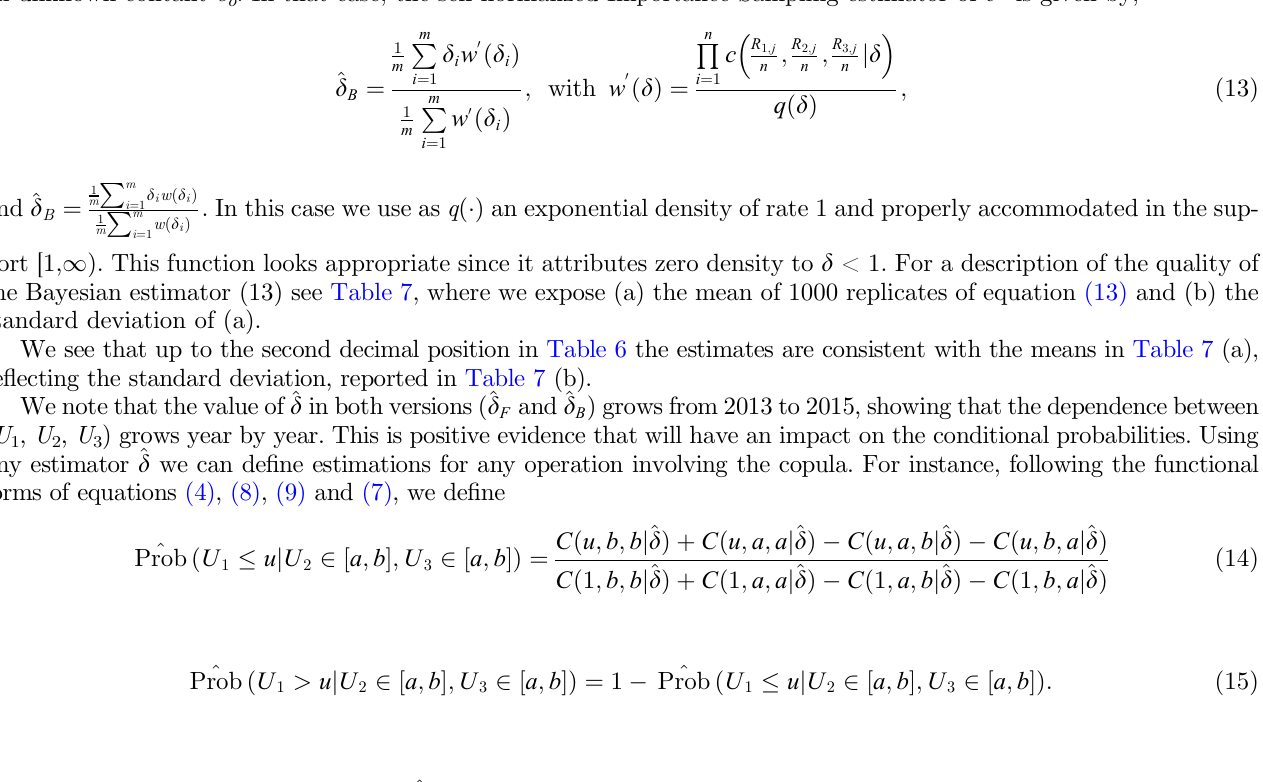
Table 6. Estimators of d – see equation (3), ^ d and F is the frequentist estimator obtained by maximization of the pseudo-loglikelihood.